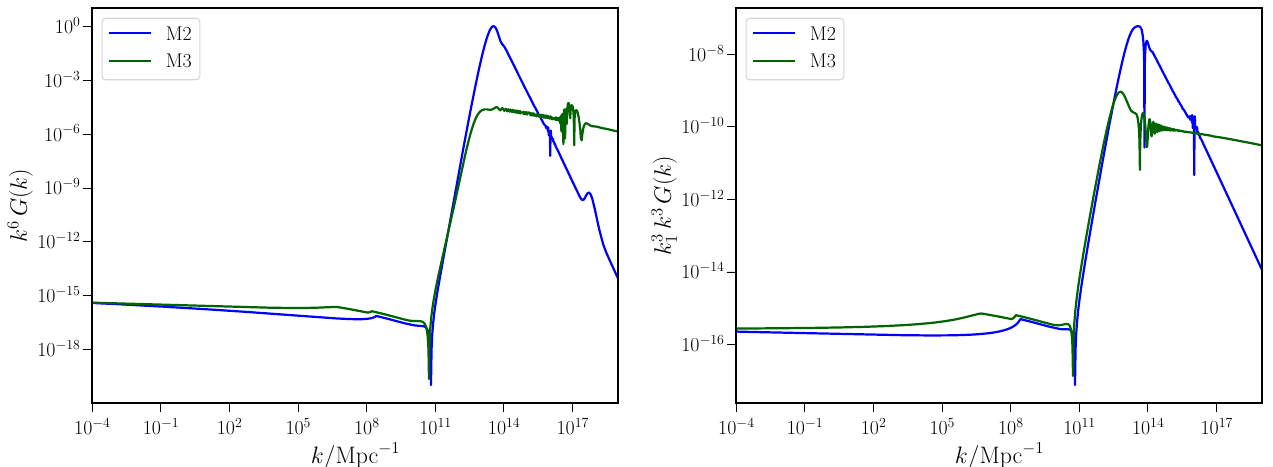
Figure 11. The behavior of the bispectrum G ( k 1 , k 2 , k 3 ) in the equilateral and squeezed limits have been plotted (on the left and right, respectively) for the two inflationary models M2 and M3 (in blue and green). We have chosen these models since they exhibit a sharp or a broad peak in their power spectra. Upon comparison with Figure 3, it is evident that the bispectra closely mimic the shapes of the corresponding power spectra. Note that, at small scales, the amplitudes of the bispectra are considerably higher in the equilateral limit than in the squeezed